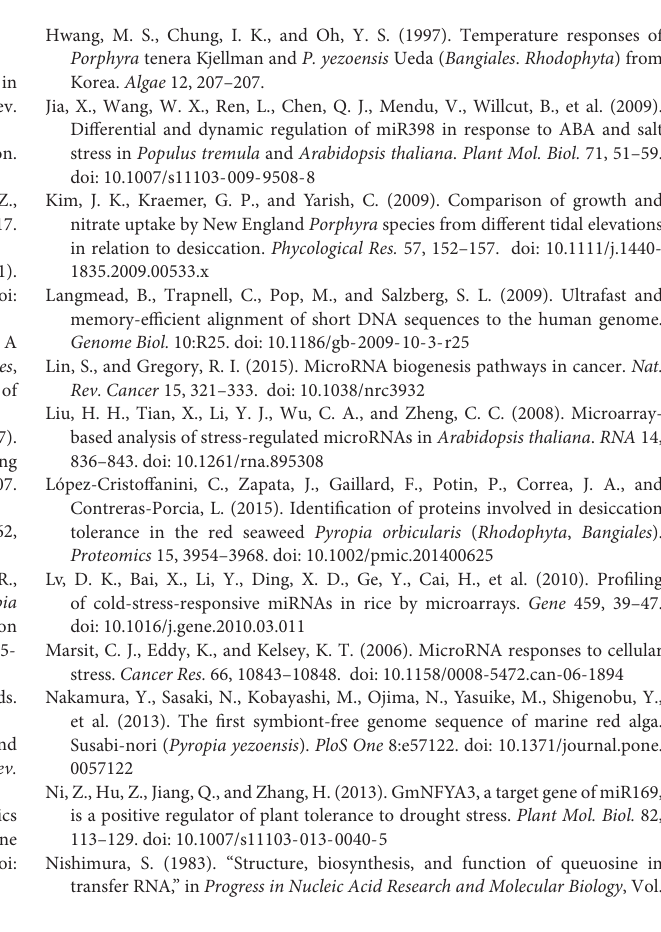
FIGURE S1 | Phylogenetic relationships of Dicer genes. FIGURE S2 | Phylogenetic relationships of AGO genes. TABLE S1 | Specific primers for miRNAs and mRNAs. TABLE S2 | Conserved miRNAs in Pyropia and C. crispus. TABLE S3 | Significant expressed miRNAs and the function of their target genes. TABLE S4 | The AGO and Dicer sequences used in this